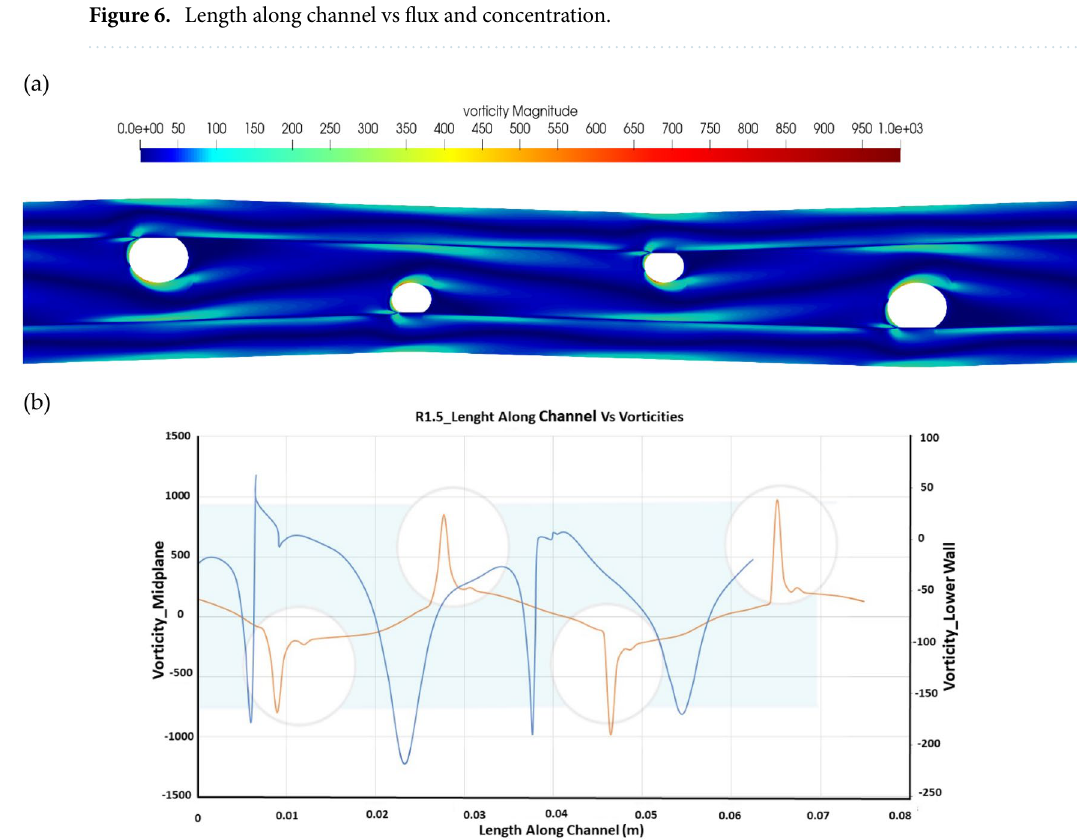
Figure 7. Vorticity plot for R1.5 ( a ) vorticity distribution along the channel and ( b ) Center line Vorticity Vs. vorticity along the lower wall of the